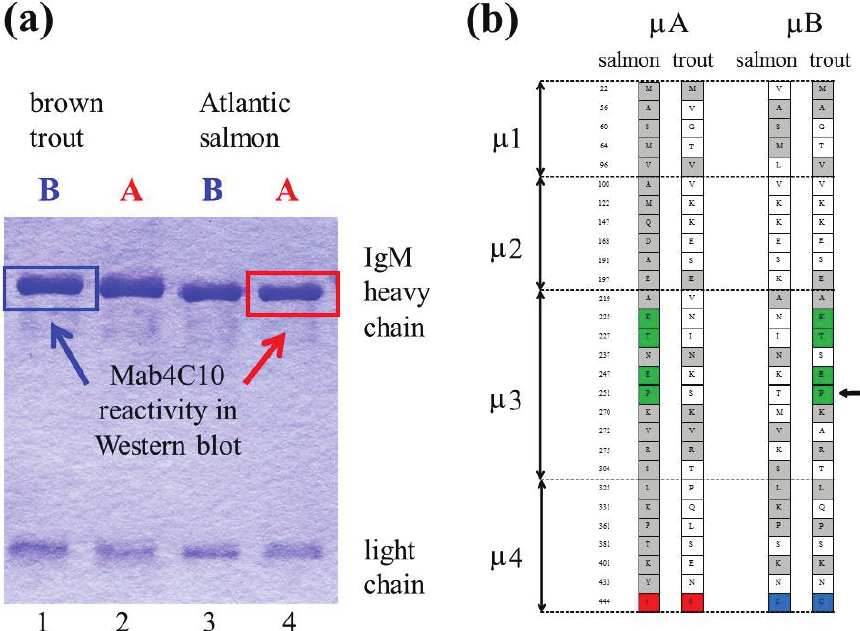
Figure 2. ( a ) A monoclonal antibody (Mab4C10) raised against rainbow trout IgM reacts exclusively with IgM-A in Atlantic salmon, whereas in brown trout it reacts with IgM-B. A coomassie stained gel of reduced IgM-B (lane 1) and IgM-A (lane 2) from brown trout, and IgM-B (lane 3) and IgM-A (lane 4) from salmon is shown (the lanes are indicated below the gel), and the reactivity with Mab4C10 is indicated with arrows ( b ) Schematic overview of amino acid substitutions in (cid:2) sub-variants of Atlantic salmon and brown trout. A cysteine residue near the C-terminal part of (cid:2)4 is characteristic for the (cid:2)B sub-variant in Atlantic salmon and brown trout (indicated with blue). Residues which are identical in salmon (cid:2)A and brown trout (cid:2)B are indicated with green. By in vitro mutagenesis and transfection experiments it was shown that a proline (indicated with an arrow) in (cid:2)3 is essential for binding of Mab4C10